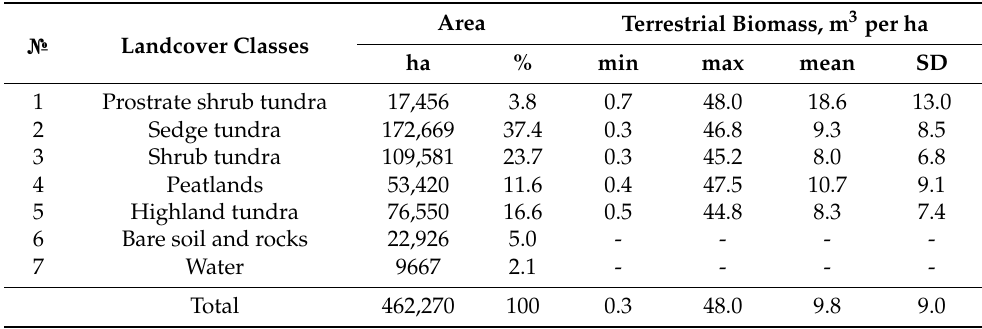
Table 1. Terrestrial biomass stock volumes for the derived landcover classes for the study area.